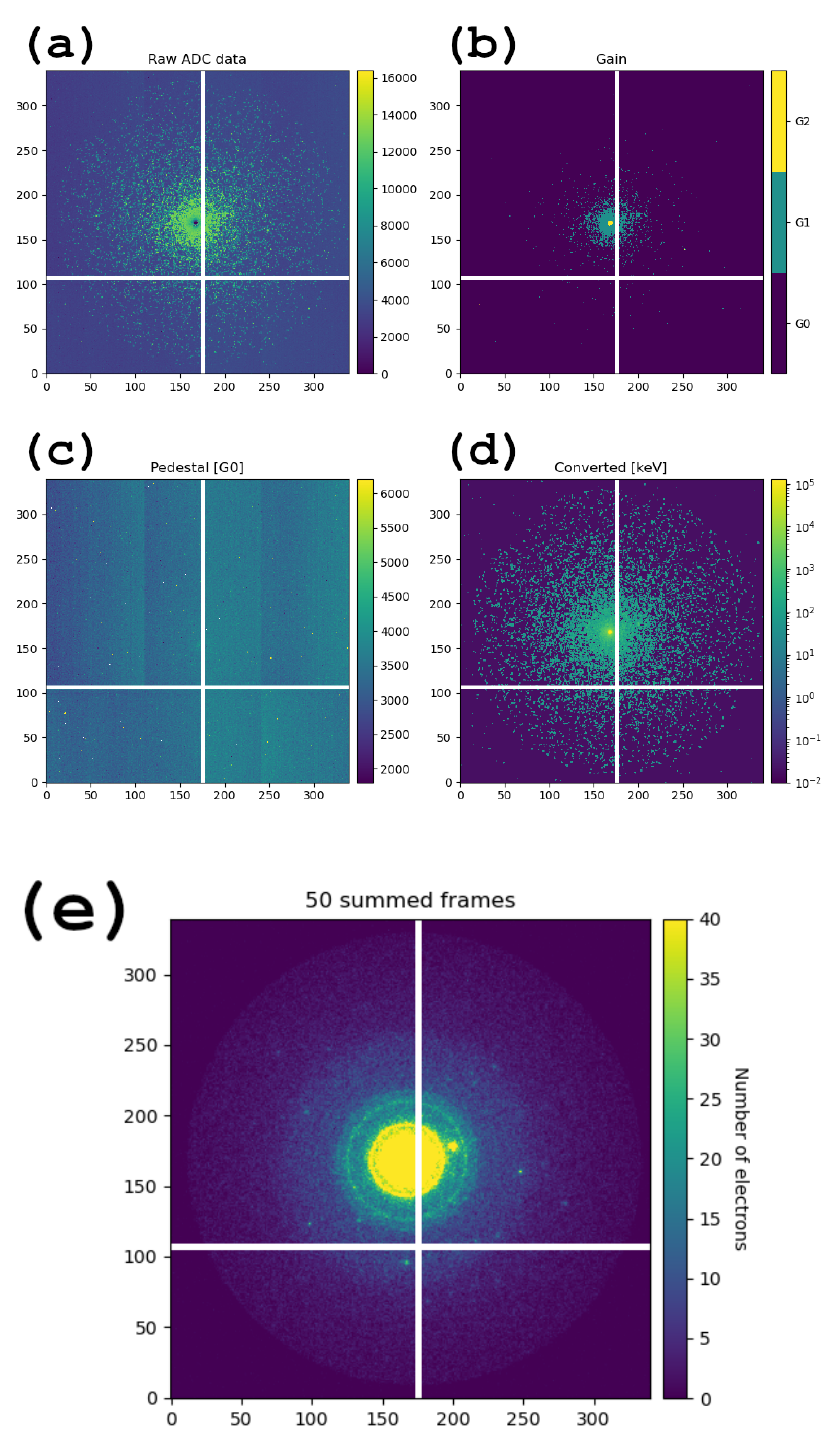
Figure 5. Similar to Figure 4, zeolite A data conversion and energy correction with the JUNGFRAU detector. ( a ) Raw data recorded in 1 ms, ( b ) gain levels per pixel, ( c ) pedestal map for gain level 0, ( d ) converted frame, ( e ) sum of 50 converted frames makes the diffraction pattern